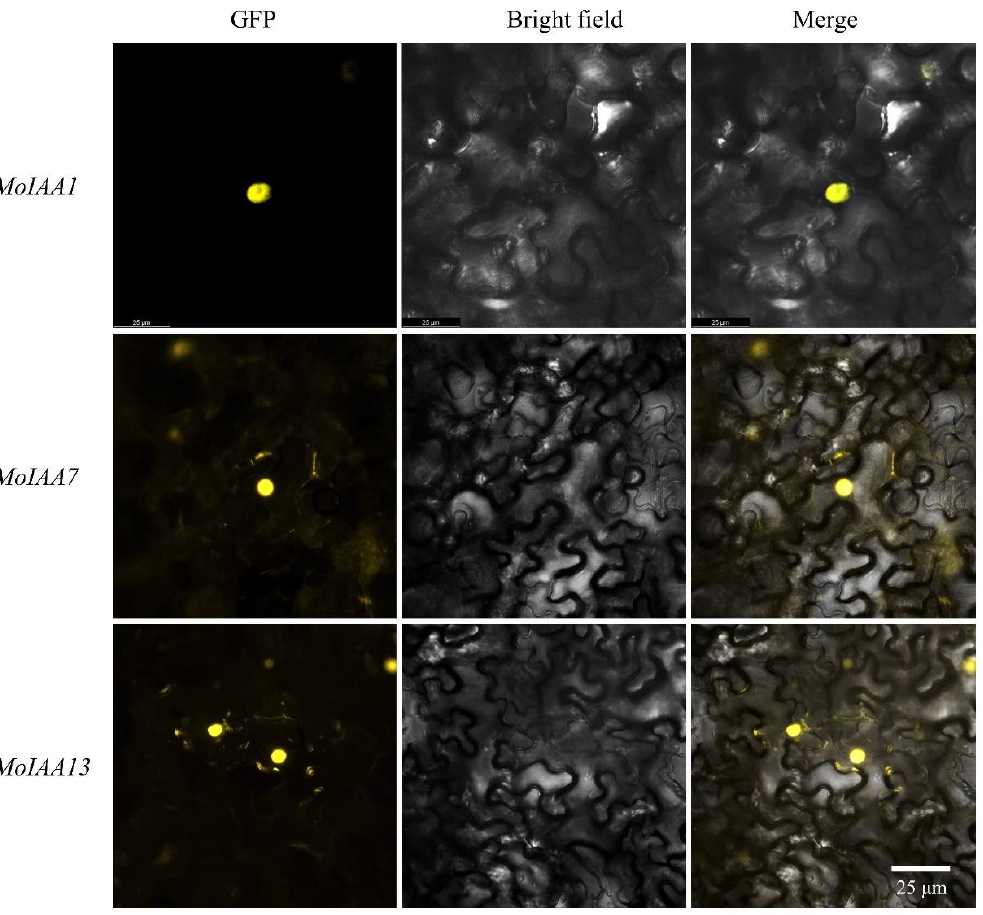
Figure 8. Subcellular localization of the MoIAA1 , MoIAA7 and MoIAA13 proteins in N. benthami- ana